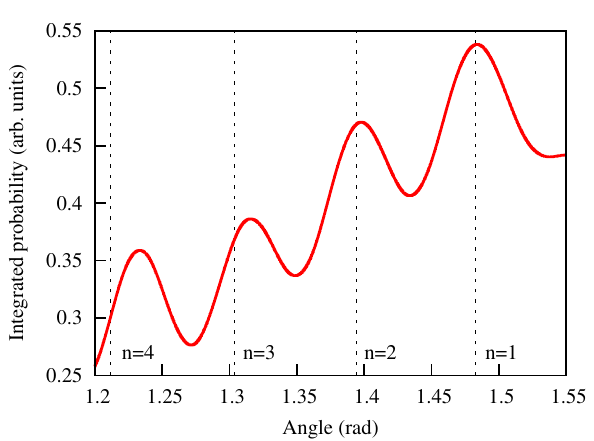
0.1 a.u., ω 0.0577 a.u. XUV field = =